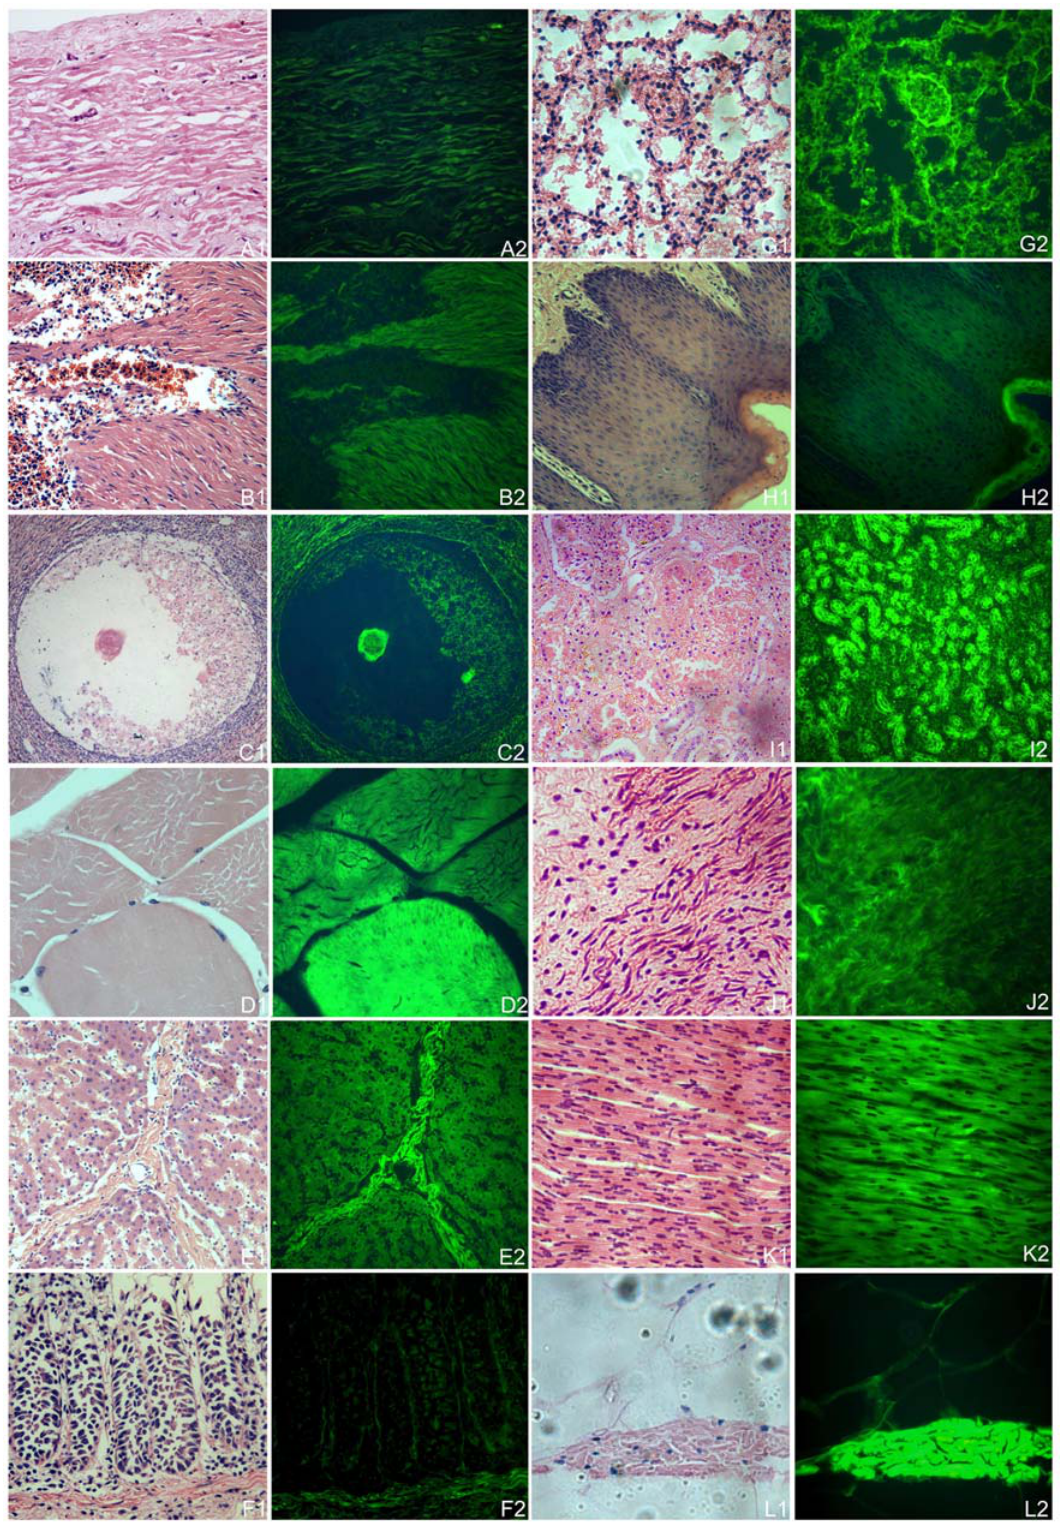
Figure 2. Variegation of GFP expression in various tissues of the transgenic pig. A to L: different tissues, namely uterus, spleen, ovary, muscle, liver, intestine, lung, tongue, kidney, stomach, heart and adipose, were visualized by HE staining. A1 to L1: tissues under normal light. A2 to L2: tissues under UV light.